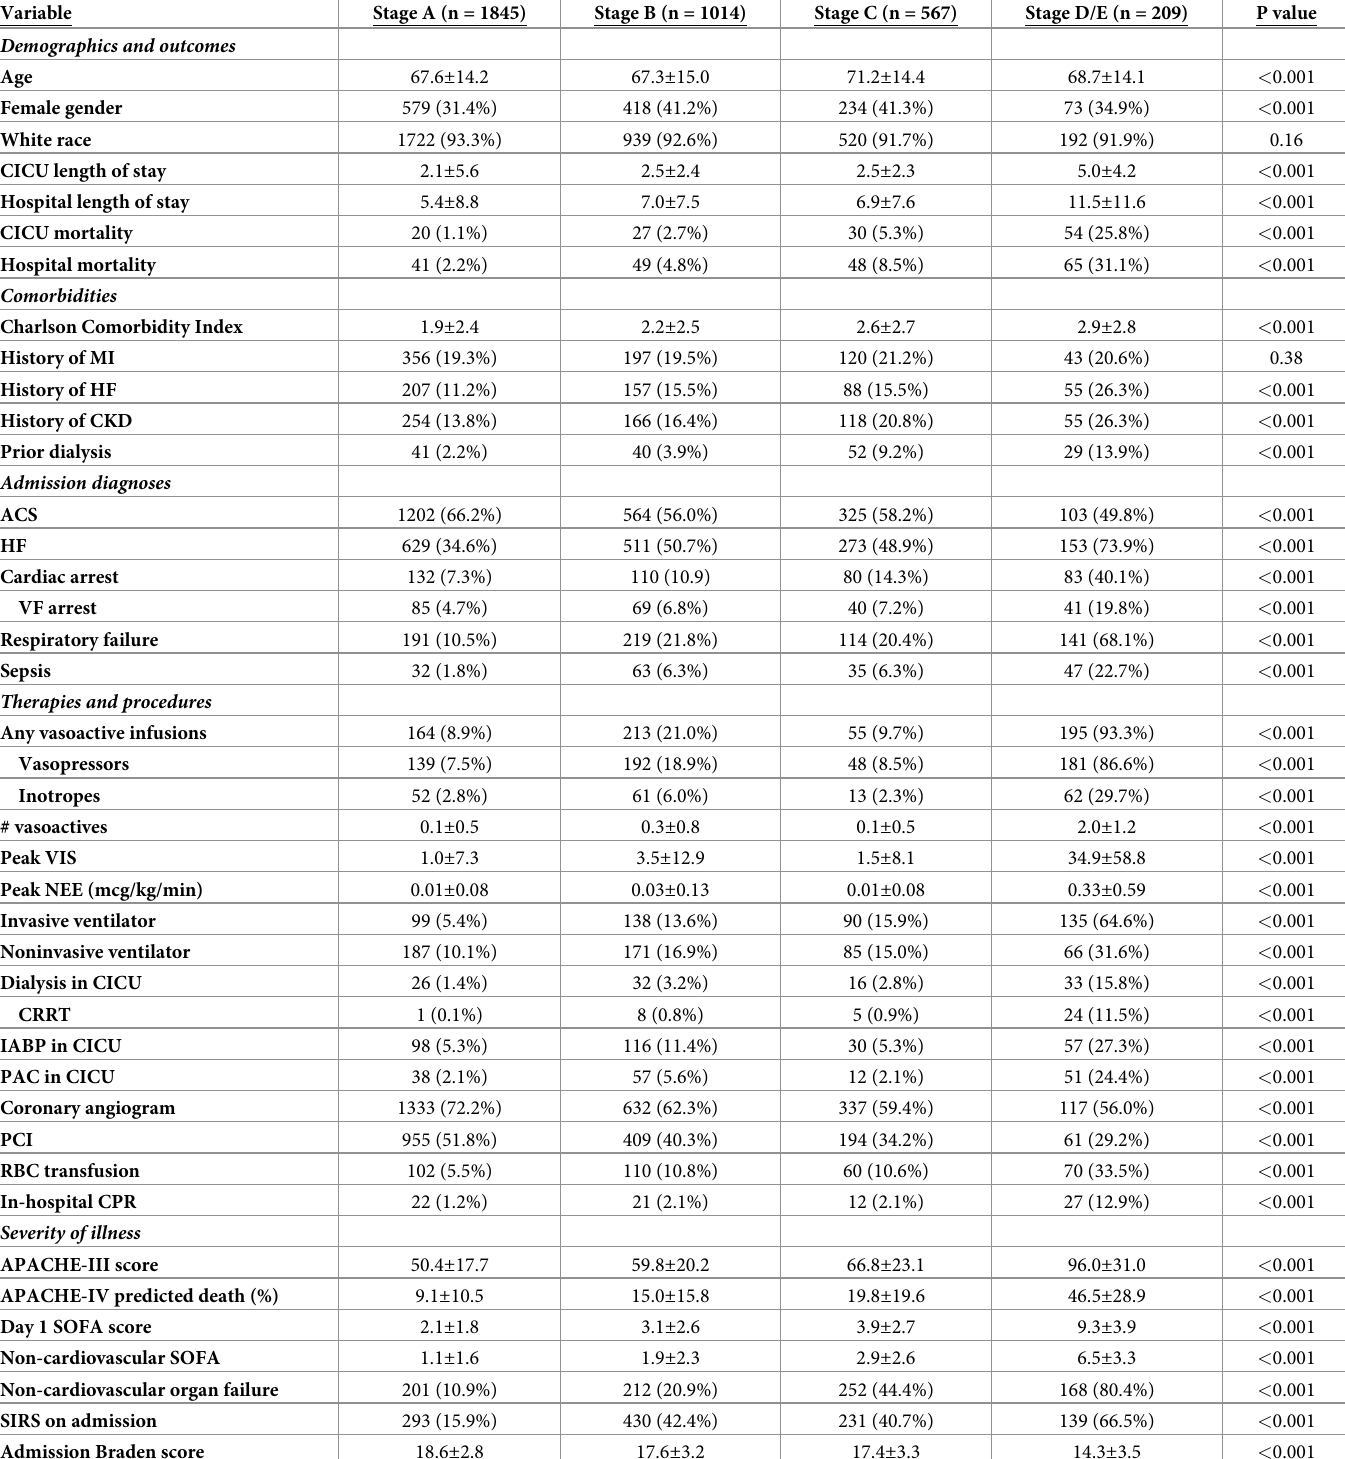
Table 1. Baseline characteristics, comorbidities, admission diagnoses and therapies of patients according to SCAI shock stages. Data reported as mean ± standard deviation for continuous variables and number (percent) for categorical variables. P value is for linear regression (continuous variables) or logistic regression (categorical variables) across SCAI shock